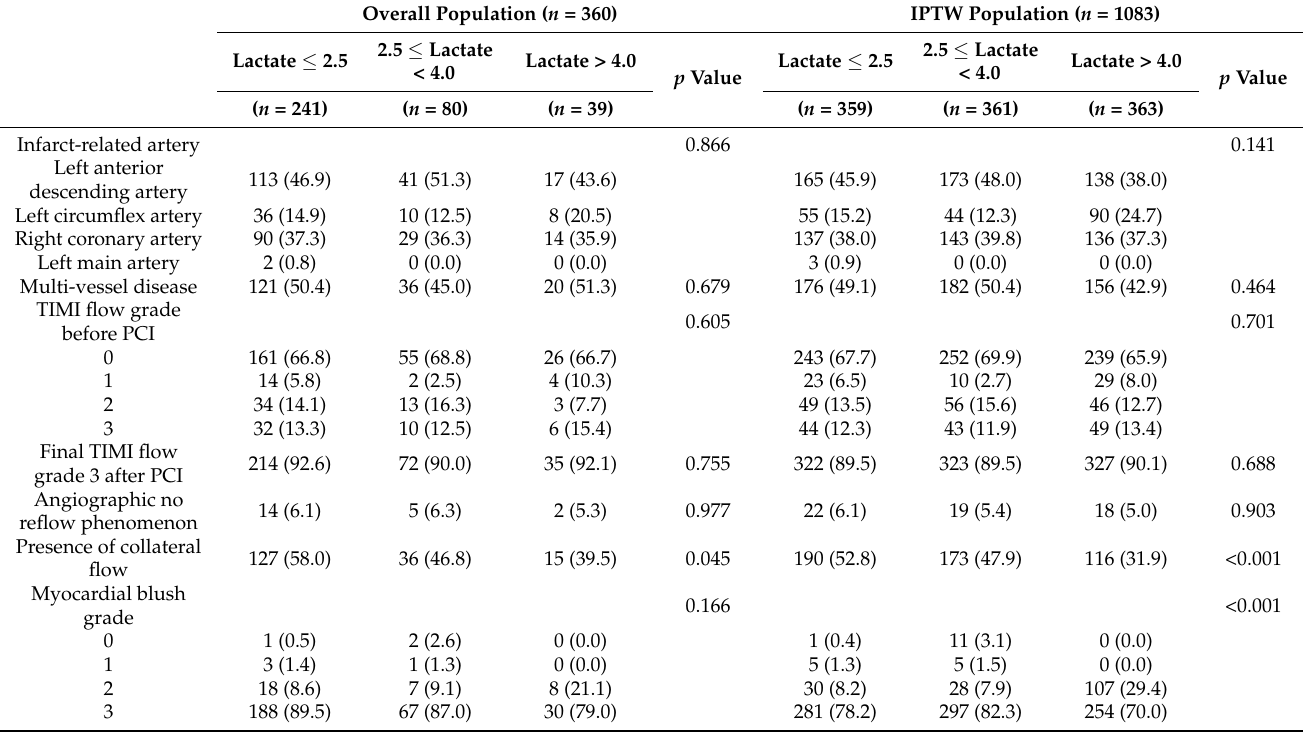
Table A2. Angiographic and procedural characteristics according to serum lactate levels